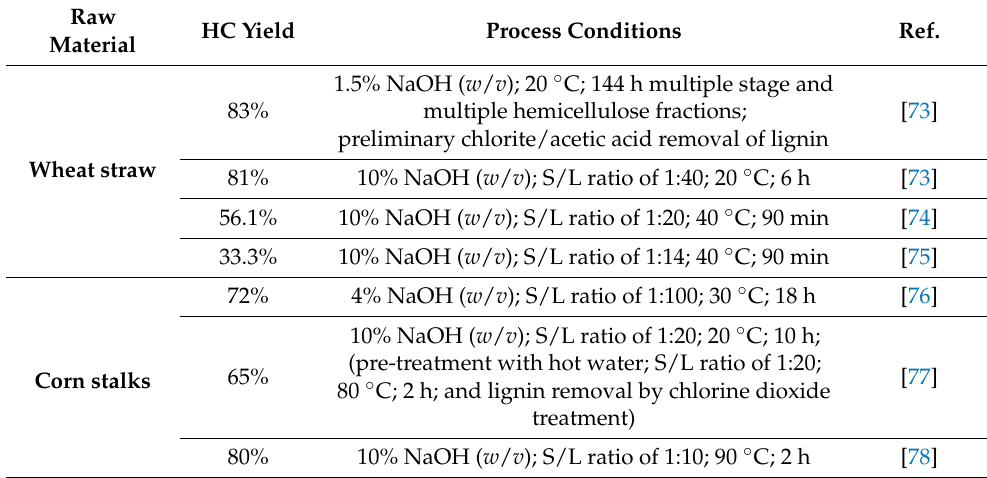
Table 7. Hemicellulose extraction yields from wheat straw and corn